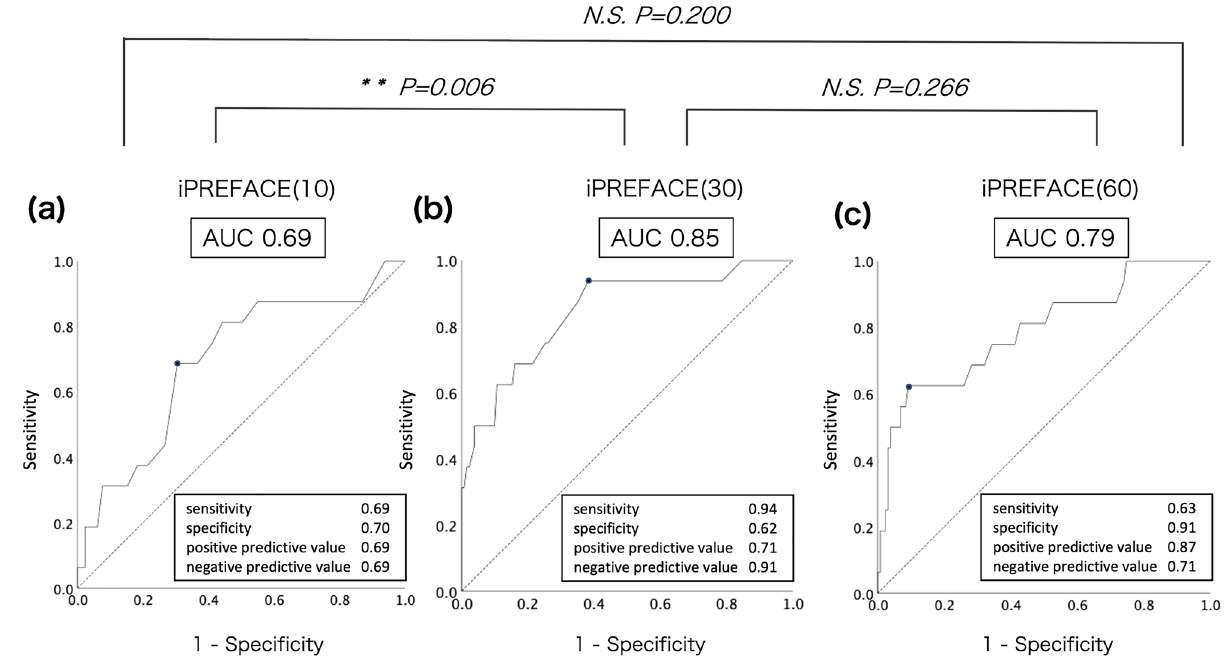
Figure 3. Comparisons of the ROC curves for umbilical artery blood pH < 7.2. ( a ) iPREFACE(10), ( b ) iPREFACE(30), ( c )